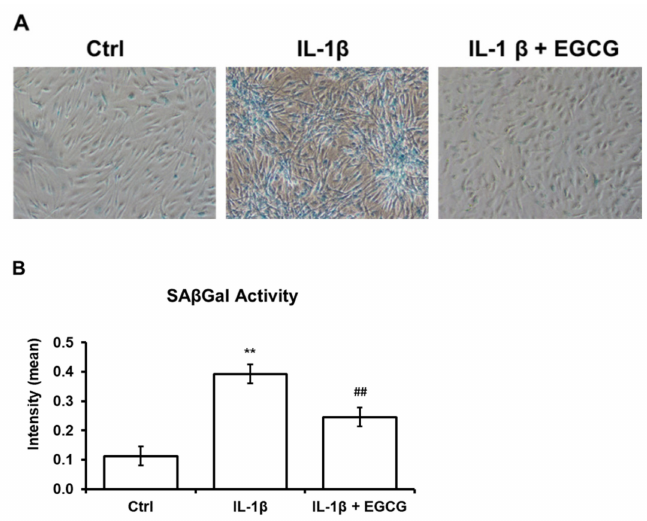
Figure 3. IL-1 β induces SA β Gal activity in cultured human articular chondrocytes. ( A ) Morphology and Sa β Gal activity in control, IL-1 β -stimulated, and EGCG-treated human articular chondrocytes. A single cell stained blue indicates SA β Gal activity. IL-1 β -stimulated cells showed a marked increase in SA β Gal activity after 48 h. SA β Gal activity was significantly reduced after EGCG treatment. ( B ) Quantification of the intensity of Sa β Gal-stained cells. The intensity of SA β Gal activity was significantly enhanced after IL-1 β stimulation but significantly reduced while cocultured with EGCG (n = 6 in each group; ** p < 0.01 versus the control group; ## p < 0.01 versus the IL-1 β -treated